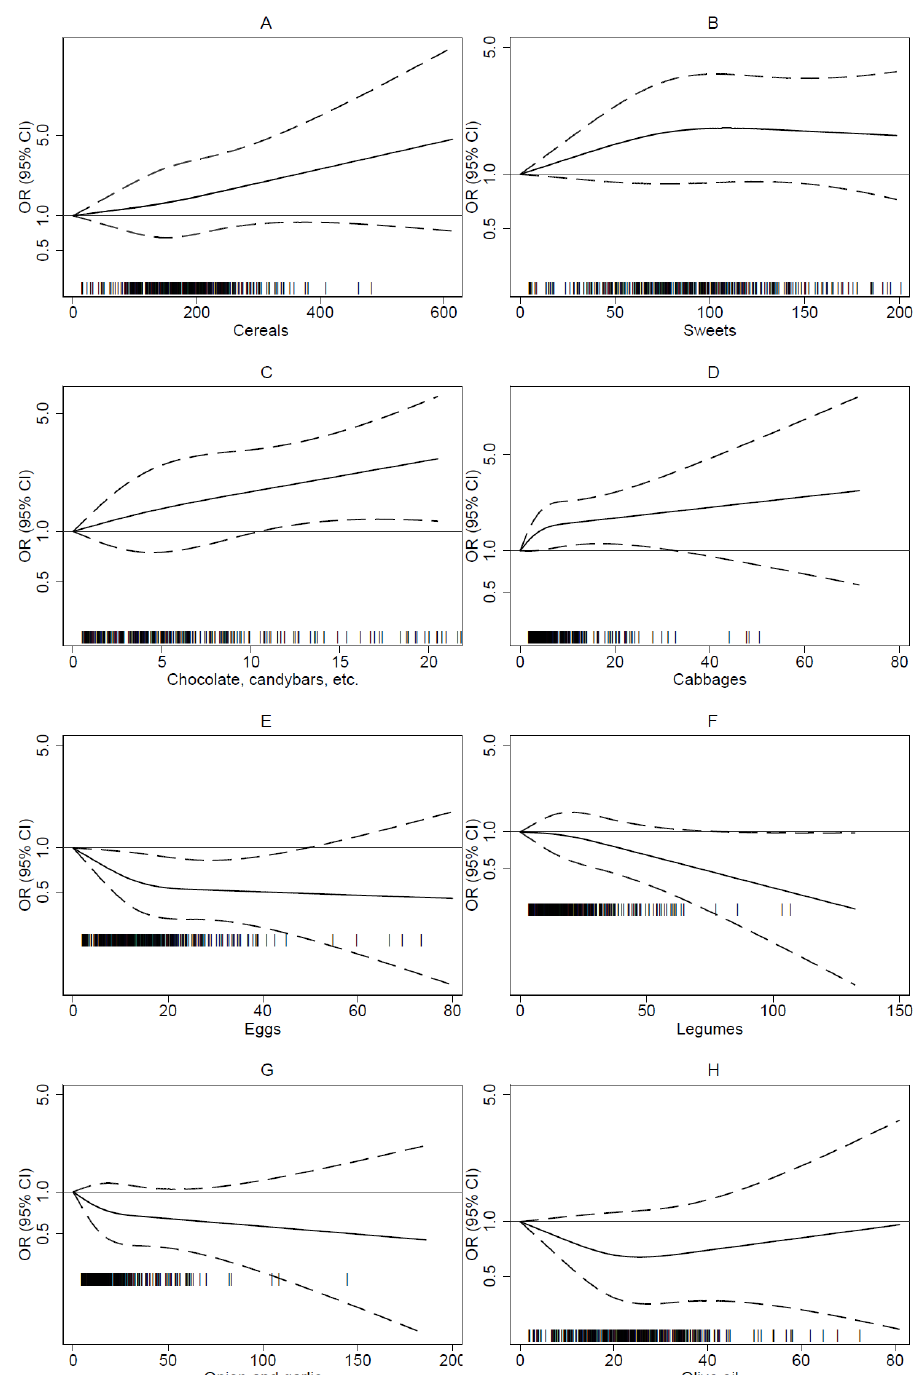
Figure 1. Spline regression analysis of the odds of being a case according to food item consumption (g / day), adjusting for phototype, sunburn history, education, body mass index, non-alcohol energy, vitamin C and vitamin D intake, Greek Mediterranean index and glycemic index; dotted lines, 95% confidence limits; reference line at 1.0. ( A ) Cereals; ( B ) Sweets; ( C ) Chocolate, candy bars, etc.; ( D ) Cabbages; ( E ) Eggs; ( F ) Legumes; ( G ) Onion and garlic; ( H ) Olive oil.